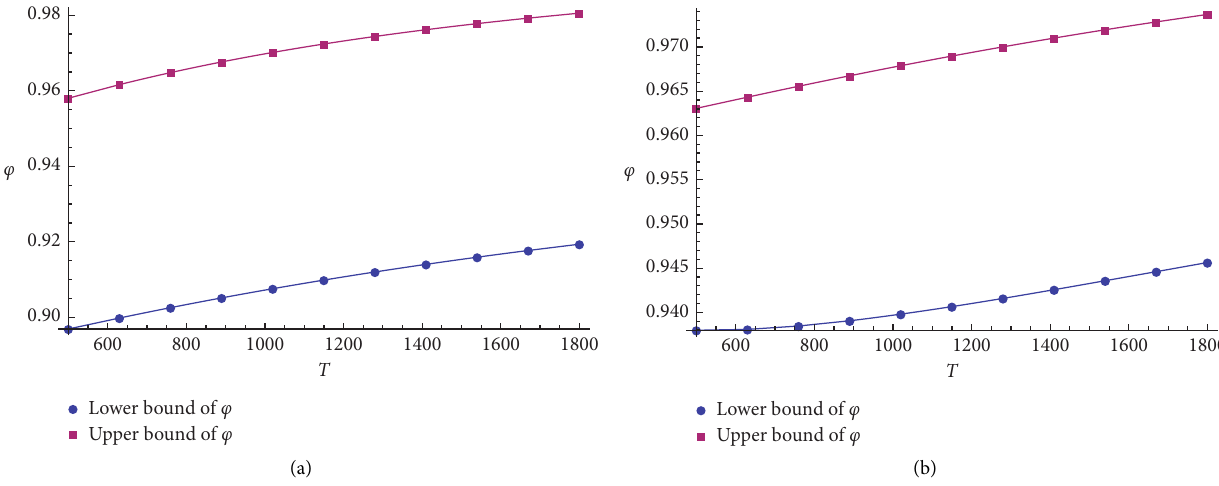
Figure 4: Change in bounds of ϕ with T : (a) case without fairness concerns; (b) case with fairness